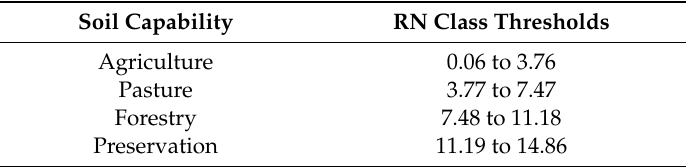
Table 4. RN class thresholds for Rio Grande